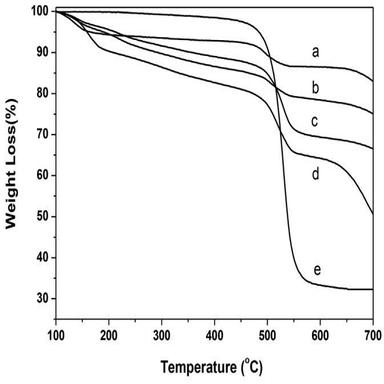
TG analysis of P3HT-MWCNT prepared by click chemistry method: (a) MWCNT; (b) acyl chlorinated MWCNT; (c) P3HT-MWCNT; (d) physical blends of P3HT and 80 wt% MWCNT; (e) P3HT.